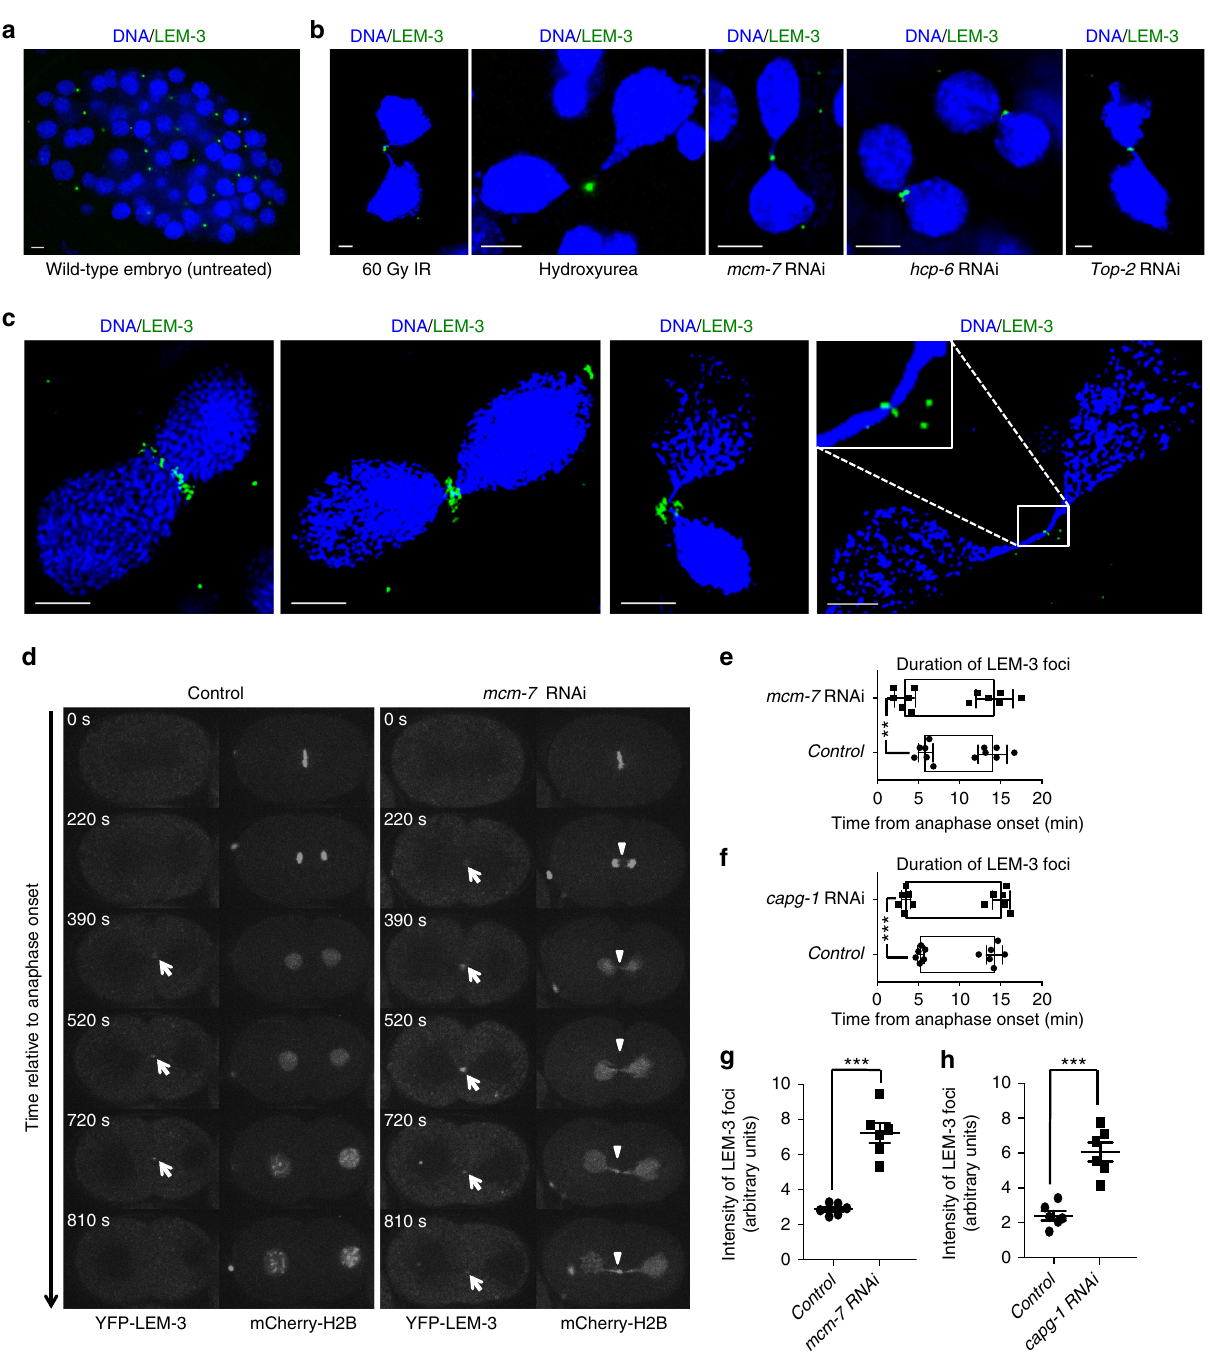
Fig. 1 Localization of LEM-3 on chromatin bridges and at the midbody. a Localization of YFP-LEM-3 in wild-type embryo. b Localization of YFP-LEM-3 on chromatin bridges generated by IR, hydroxyurea, and RNAi depletion of replicative helicase subunit MCM-7, condensin II component HCP-6 and topoisomerase TOP-2. c Representative OMX images of YFP-LEM-3 localization at different stage of chromosome segregation in the presence of chromatin bridges induced by mcm-7 RNAi. Scale bars: 2 μ m. d Localization of LEM-3 on chromatin bridges induced by mcm-7 RNAi. Arrows indicate YFP- LEM-3. Arrowheads indicate the chromatin bridges. Times are relative to anaphase onset of the fi rst division. e , f Quanti fi cation of the average time duration of GFP-LEM-3 localization at the midzone/midbody during the fi rst mitotic cell division in wild type, mcm-7 RNAi ( e ) and capg-1 RNAi ( f ) embryos. Error bars represent standard deviation of the mean. g , h Quanti fi cation of the intensity of GFP-LEM-3 foci during the fi rst mitotic division in wild type, mcm-7 RNAi ( g ) (measured at 2.5 min after fi rst appearance of LEM-3 foci) and capg-1 RNAi ( h ) embryos. Asterisks indicate statistical signi fi cance as determined by two-tailed Student t -test. p values below 0.05 were consider signi fi cant, where p < 0.05 was indicated with *, p < 0.01 with **, and p < 0.001 with